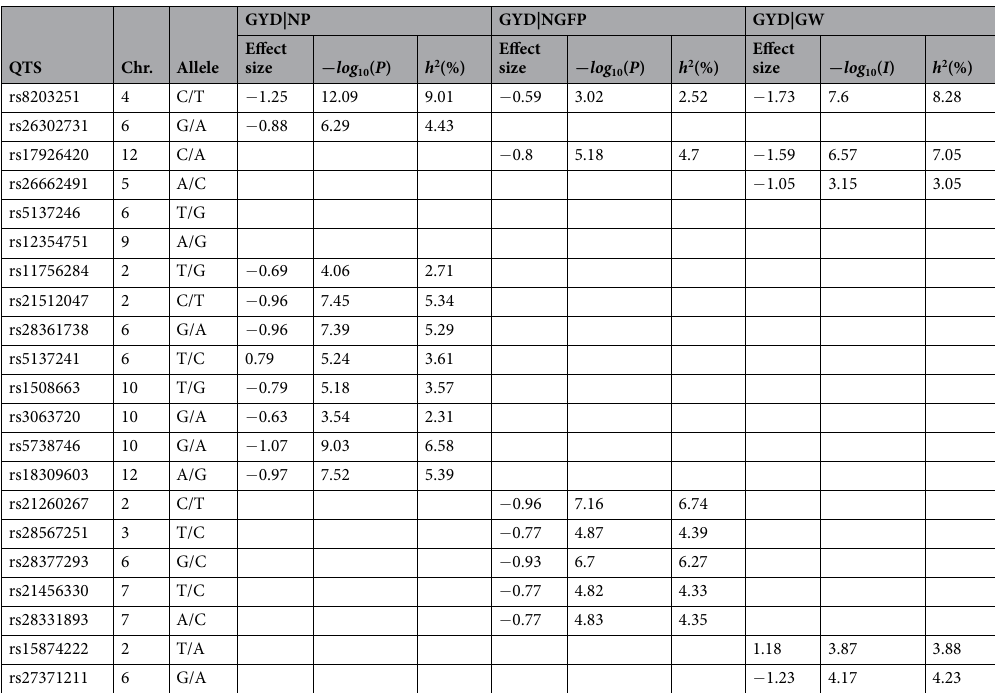
Table 4. The estimated heritability and predicted genetic effects of all detected SNP loci for grain yield conditioned by its component traits. QTS, Chr., Allele, − log 10 ( P ), h 2 (%), GYD, NP, NFGP, GW have same definitions as those in Table